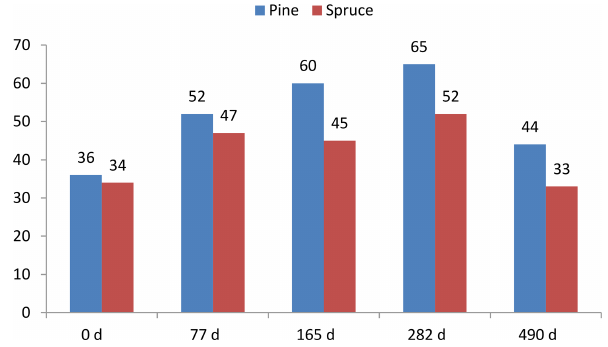
Figure 1. Changes in the number of different VOCs registered in emissions from decomposing Scots pine and Norway spruce nee- dles (Isidorov et al.,